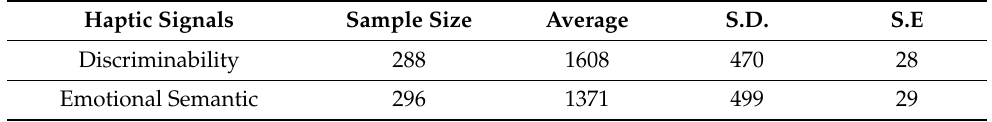
Table 9. t -test analysis results for response time.